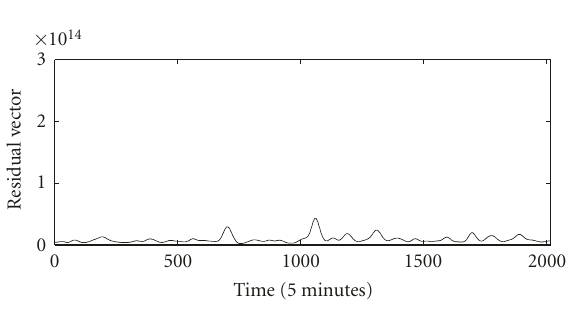
Figure 6: PCA for two anomalies in two